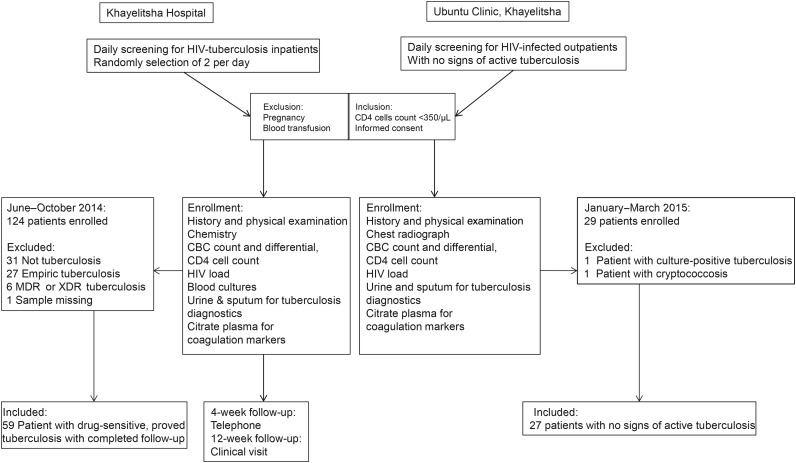
Study flow. Flow diagram showing an overview of methods, patient recruitment, and criteria for inclusion in this study. Between June and November 2014, we recruited adult patients immunodeficiency virus (HIV) infection, CD4 cell counts <350/µL, and a tuberculosis diagnosis or a high clinical suspicion of tuberculosis on admission to Khayelitsha Hospital. Patients who were pregnant or received a blood transfusion were excluded, and only patients with microbiologically proved rifampicin-susceptible tuberculosis were included in the analyses. A random selection procedure was used to select 2 eligible patients on each weekday. As controls, HIV-infected outpatients with CD4 cell counts <350/µL but active tuberculosis were recruited at the Ubuntu Clinic in Khayelitsha. Abbreviations: CBC, complete blood cell; MDR, multidrug resistant; XDR, extensively drug resistant.